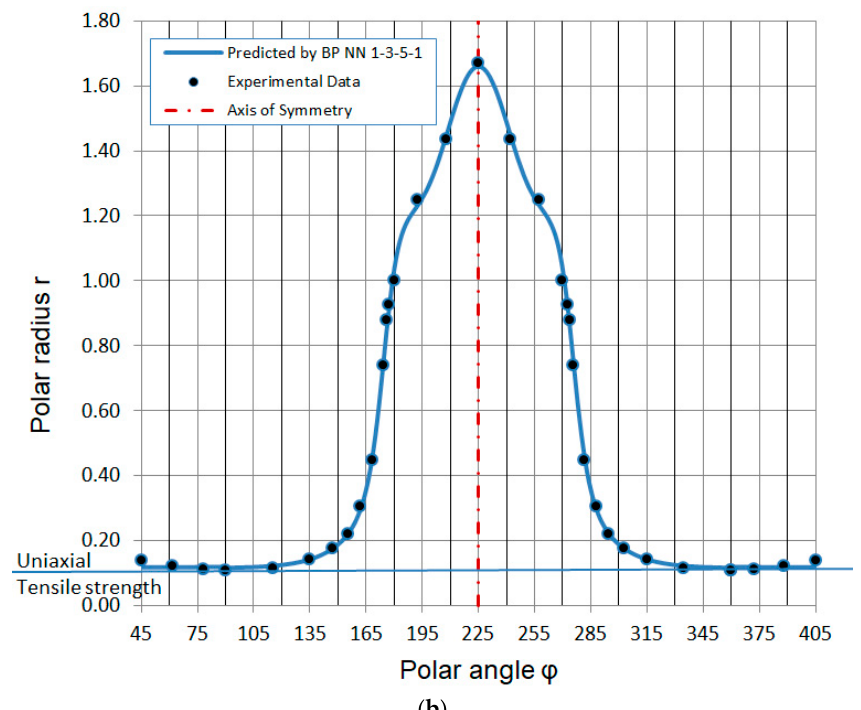
Figure 12. Concrete failure criterion under biaxial stress state: ( a ) in dimensional principal stresses terms; and ( b ) in polar coordinates.